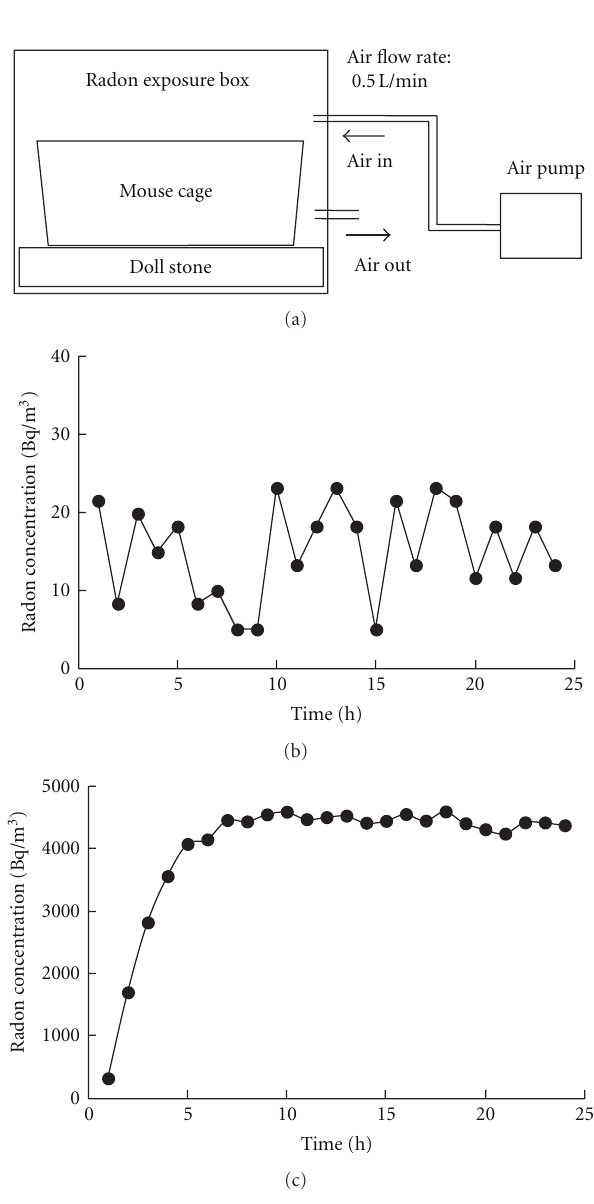
Figure 1: Schematic diagram of the radon exposure system (a). Changes in the radon concentration in the mouse cage over the period of sham (b) or radon inhalation